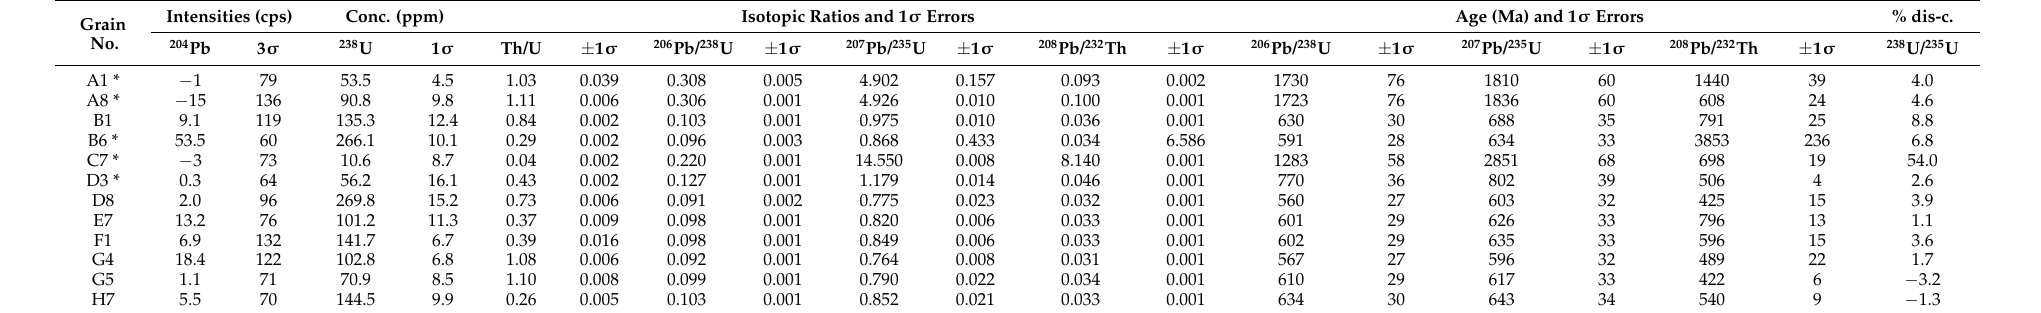
Table 2. Zircon U-Th-Pb Data for the studied